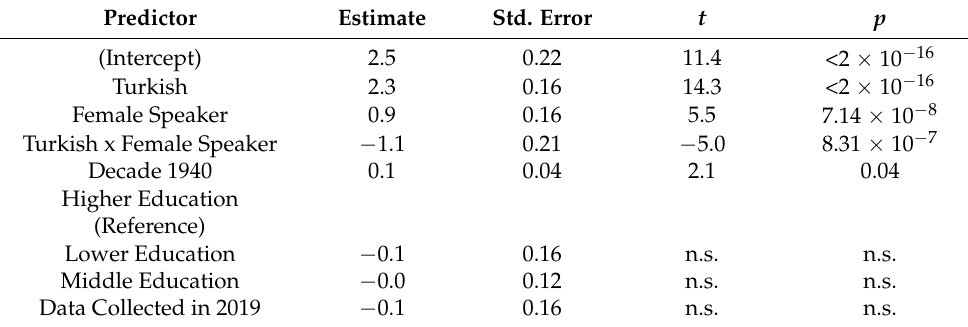
Table 7. Linear Model—Outcome Variable: Archaic Migrant 1 .